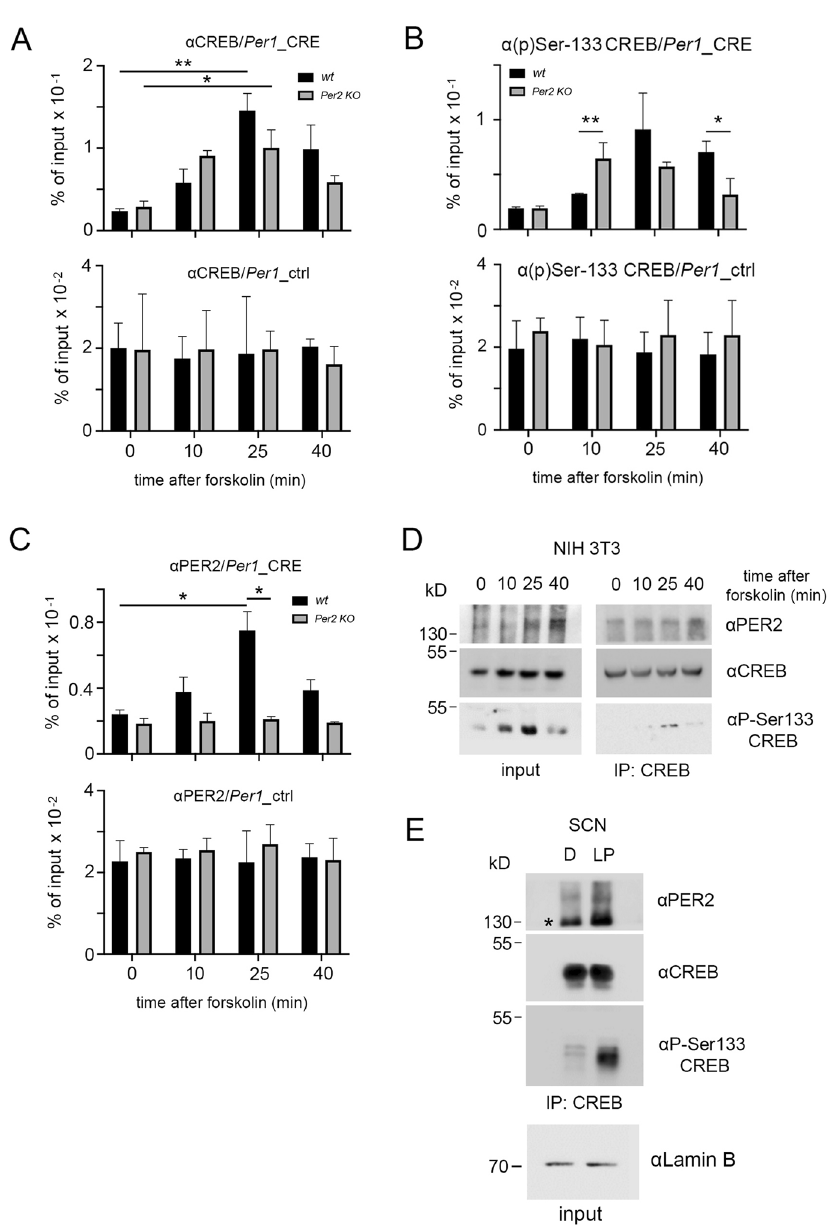
Figure 2. Binding of CREB and PER2 to the CRE-element of the Per1 promoter and interaction between CREB and PER2. ( A ) Top panel: Chromatin immunoprecipitation (ChIP) of CREB on the CRE-element of the Per1 promoter in wt (black bars) and Per2 KO (grey bars) fibroblast cell lines after forskolin treatment. Bottom panel: Control ChIP on an unrelated promoter region of Per1. Values are the mean ± SD. Student’s t-test with Welch’s correction, n = 3, * p < 0.05, ** p < 0.01. Two-way ANOVA indicates a significantly different time profile between the two genotypes, ** p < 0.01. ( B ) Top panel: ChIP of pSer-133 CREB on the CRE-element of the Per1 promoter in wt (black bars) and Per2 KO (grey bars) fibroblast cell lines after forskolin treatment. Bottom panel: Control ChIP on an unrelated promoter region of Per1. Values are the mean ± SD. Student’s t-test with Welch’s correction, n = 3, * p < 0.05. Two-way ANOVA indicates a significantly different time profile between the two genotypes, ** p < 0.01. ( C ) Top panel: ChIP of PER2 on the CRE-element of the Per1 promoter in wt (black bars) and Per2 KO (grey bars) fibroblast cell lines after forskolin treatment. Bottom panel: Control ChIP on an unrelated promoter region of Per1. Values are the mean ± SD. Student’s t-test with Welch’s correction, n = 3, * p < 0.05. Two-way ANOVA indicates a significantly different time profile between the two genotypes, ** p < 0.01. ( D ) Western blot (left panel) was performed on 10% of the total input used for the immunoprecipitation using a CREB antibody as bait (right panel). PER2 co-precipitates with CREB in NIH 3T3 cell extracts, the pSer-133 antibody was used to confirm the forskolin induction. kD = kilo Dalton. ( E ) IP with an antibody recognizing CREB in SCN extracts, which co-precipitated with PER2 before ( D ) and after a 15 min light pulse (LP) at ZT14. The pSer-133 antibody was used to confirm light induction. Input control with lamin B (bottom panel), kD = kilo Dalton. *Unspecific band recognized by the αPER2 antibody in tissue